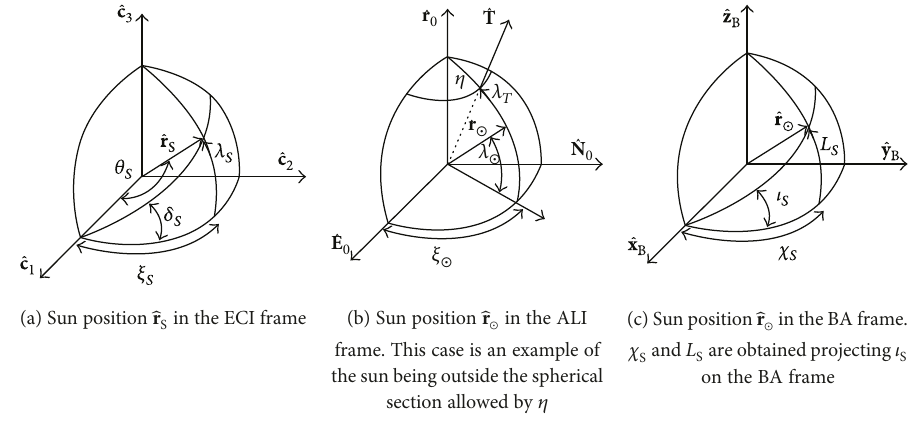
Figure 8: Sun-pointing guidance principal angles and